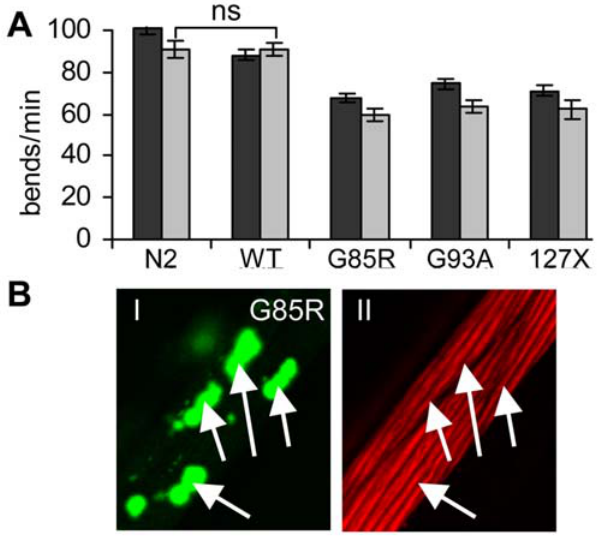
Figure 4. SOD1 mutants exert mild toxicity in the body-wall muscle cells. ( A ) Body bends of individual animals per minute were measured. Expression of mutant SOD1 proteins lead to 25 to 30% decrease in motility on day 2 of adulthood (dark grey bars), and further decrease by approximately 10% on day 6 of adulthood (light grey bars). Error bars are standard error of the mean, n $ 15. P , 0.001 between N2 and each SOD1 strain, except where indicated (ns). ( B ) SOD1 aggregation does not disrupt the myofilaments structure. Panel I shows distribution of G85R aggregates in several muscle cells, panel II shows Rhodamine-phalloidin staining of filaments in same cells. Both panels represent a single confocal plane with aggregates ( I ) or filaments ( II ) in focus.